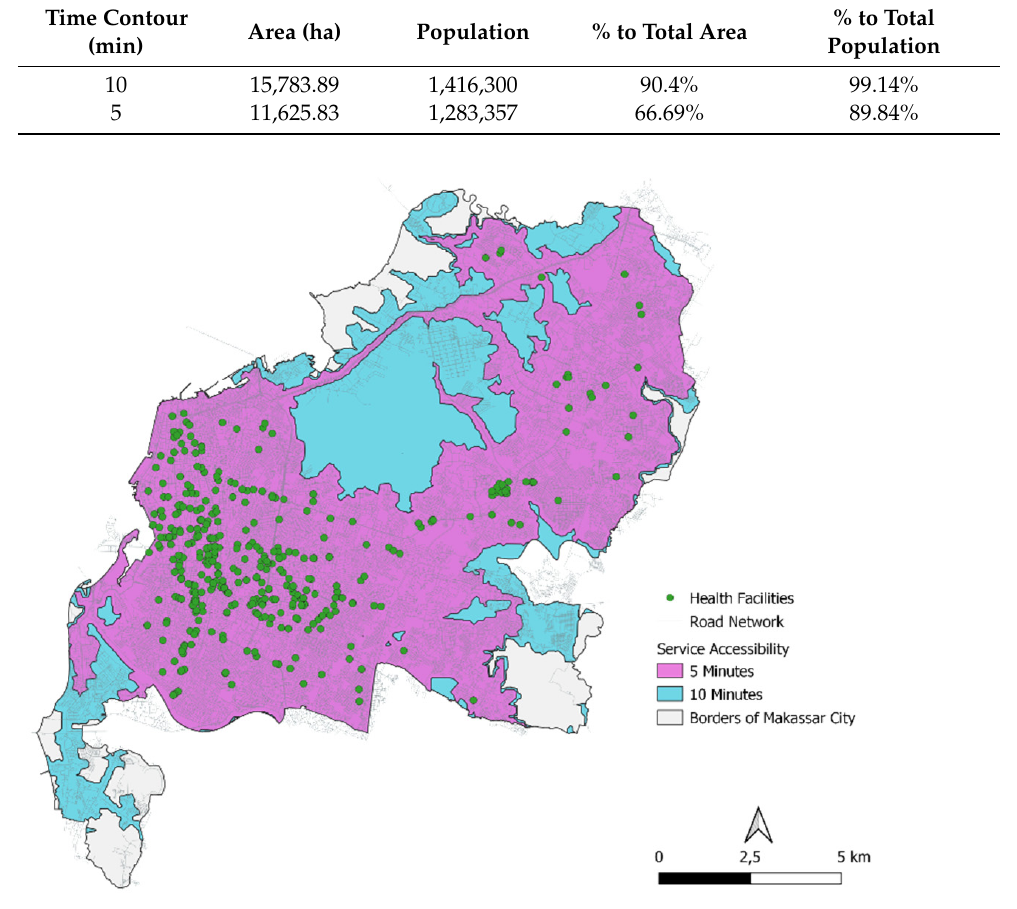
Table 5. Service Range of Health Facilities in 5-Minutes Drive.